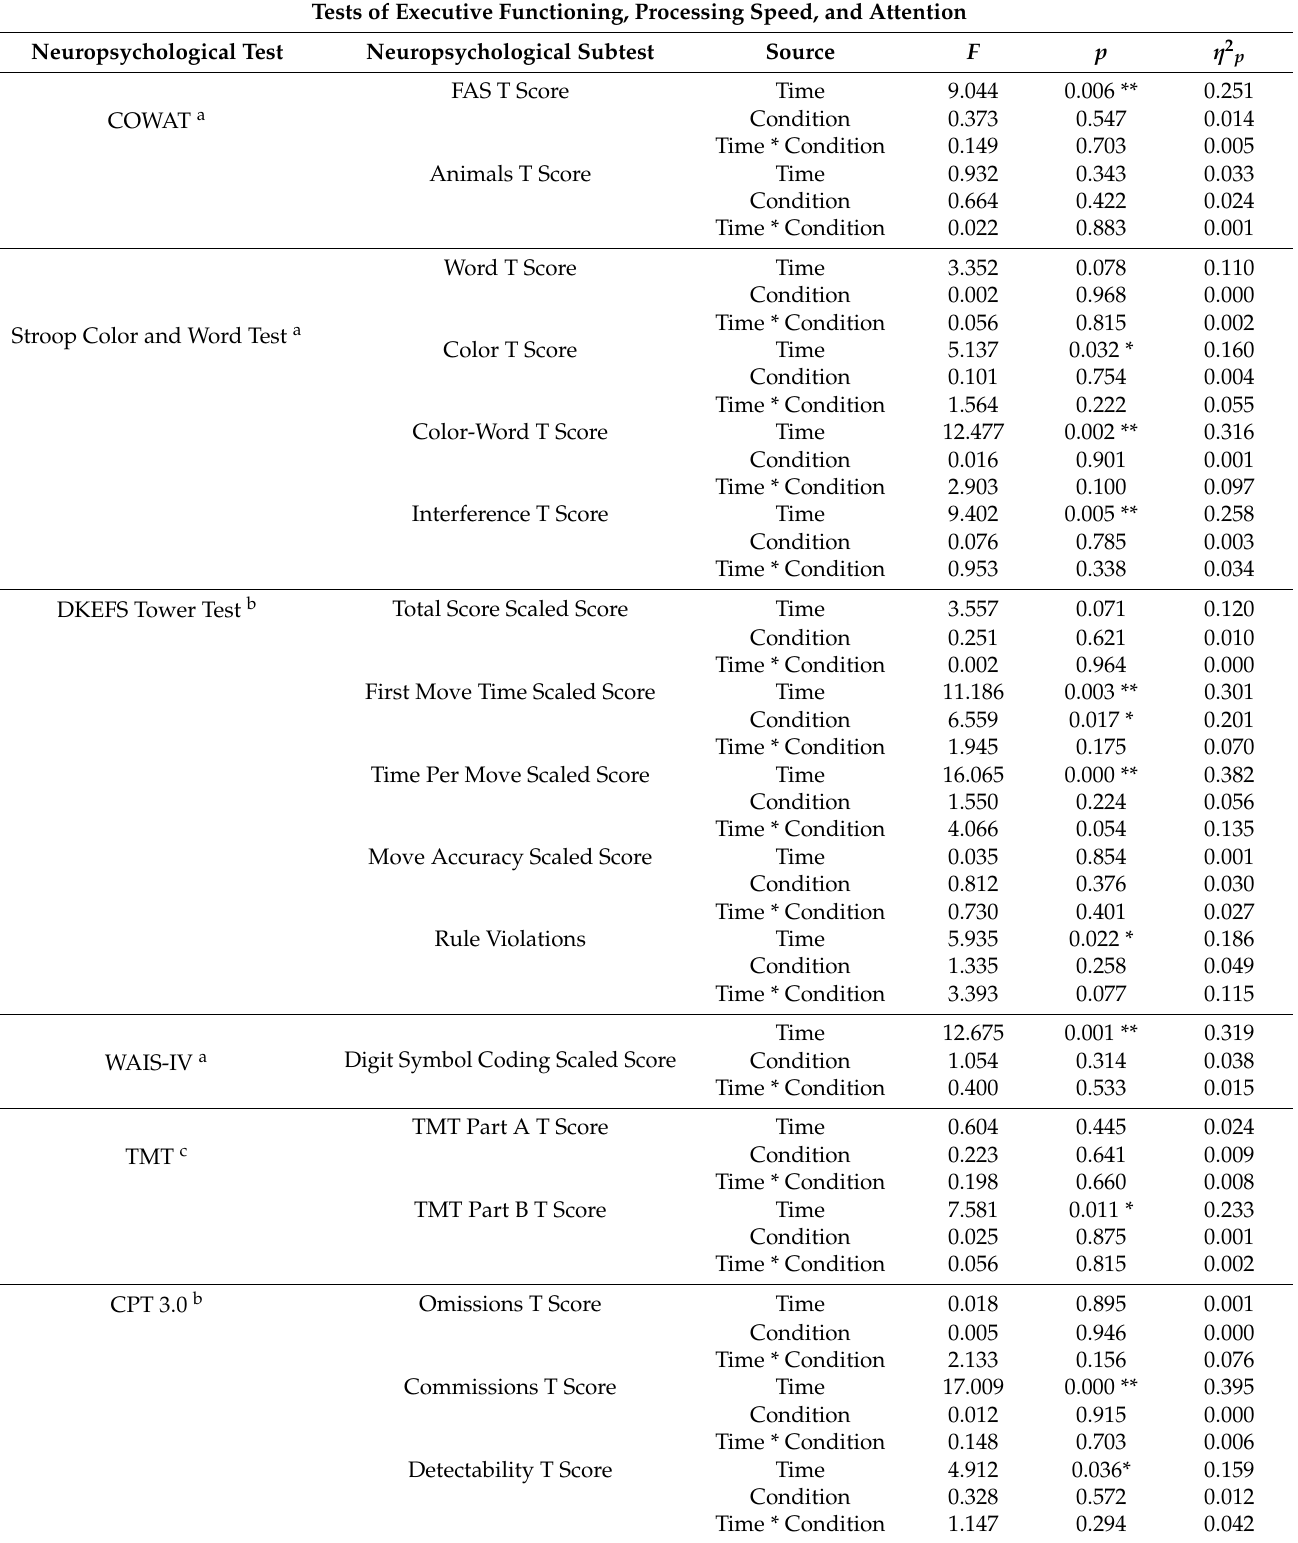
Table 3. 2 × 2 ANOVA table for neuropsychological